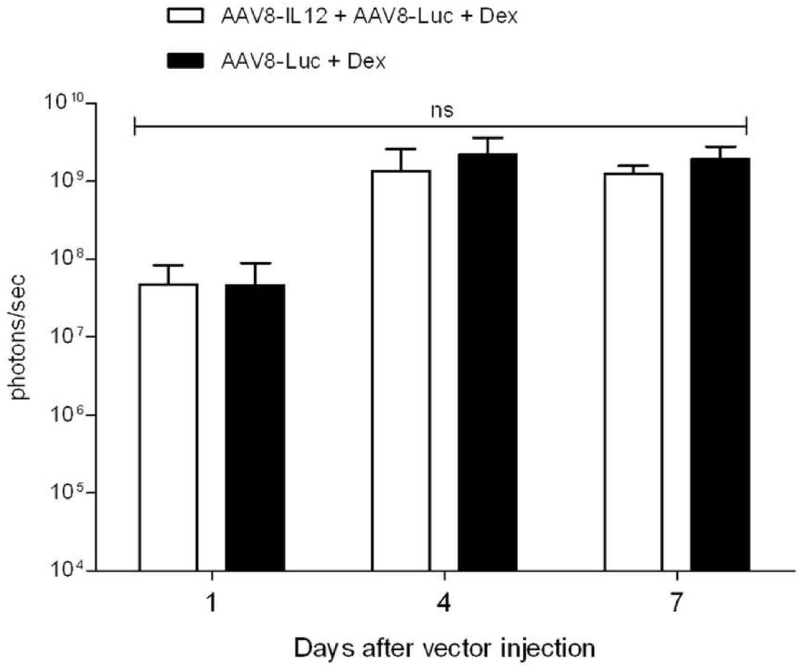
Figure 5. Anti-inflammatory treatment blocks the IFN- c inhibitory effect. C57BL/6 mice received 2.5 6 1011 vg/kg of AAV8-luc vector alone or in combination with 1.5 6 109 vg/kg of AAV8-IL12 vector. Two groups of 5 mice each were injected with AAV8-luc or AAV8-luc in combination with AAV8-IL12 and received Dexamethasone (Dex) as described in methods. Luciferase expression levels were analyzed in both groups of animals at days 1, 4, and 7 using a Xenogen in vivo luminometer. Luciferase expression was quantified and represented as photons/second. The data are shown as mean 6 standard deviation (SD). The differences in luciferase expression were statistically evaluated by Student t test (ns, not significant).